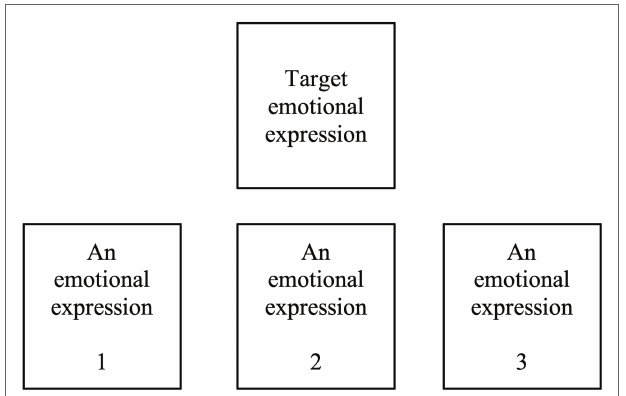
FIGURE 1 | An example of one Facial Expressions Matching Test (FEMT) trial (for details see Szczygieł et al.,